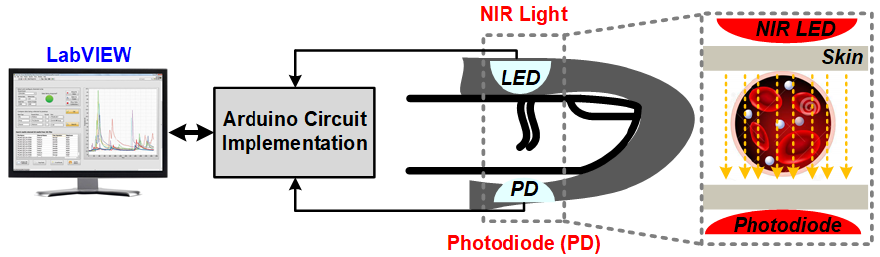
Figure 5. A prototype for the NIR transmission spectroscopy using a 940 nm wavelength for a noninvasive glucose monitoring system.